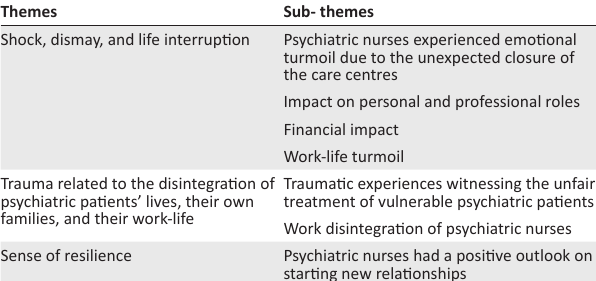
TABLE 2: Themes and Sub-themes of psychiatric nurses’ experience after the closure of Life Esidimeni psychiatric care centres